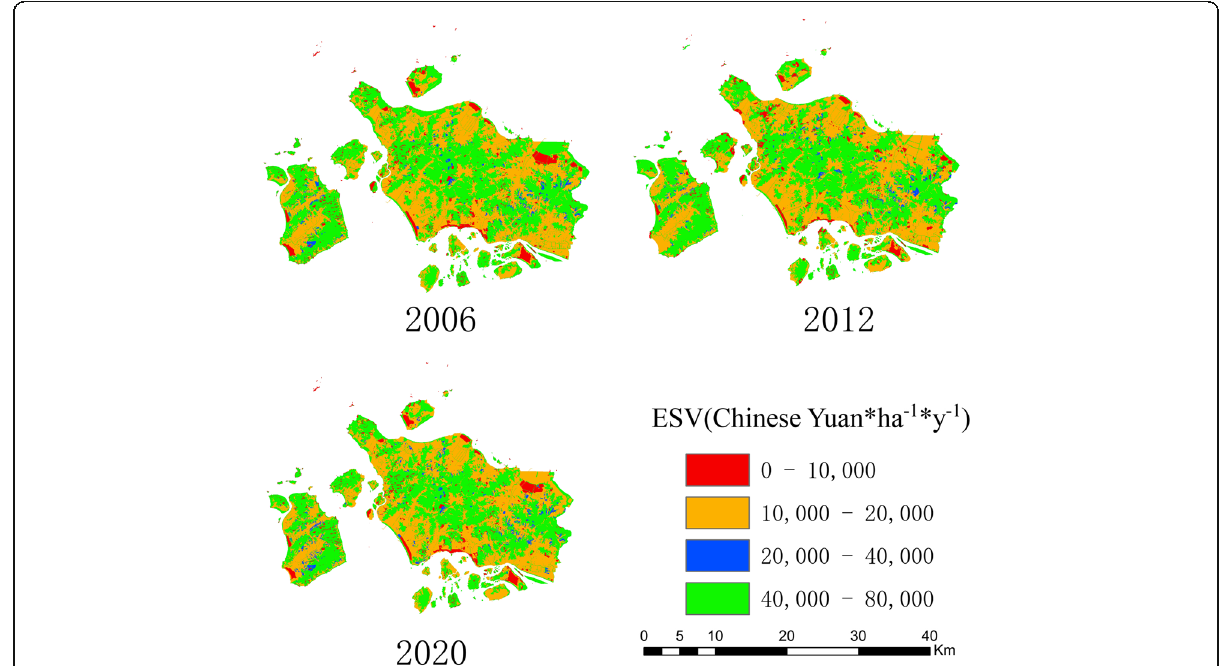
Fig. 5 Spatial distribution of the ESV values in the Dinghai District in 2006, 2012, and the planned year